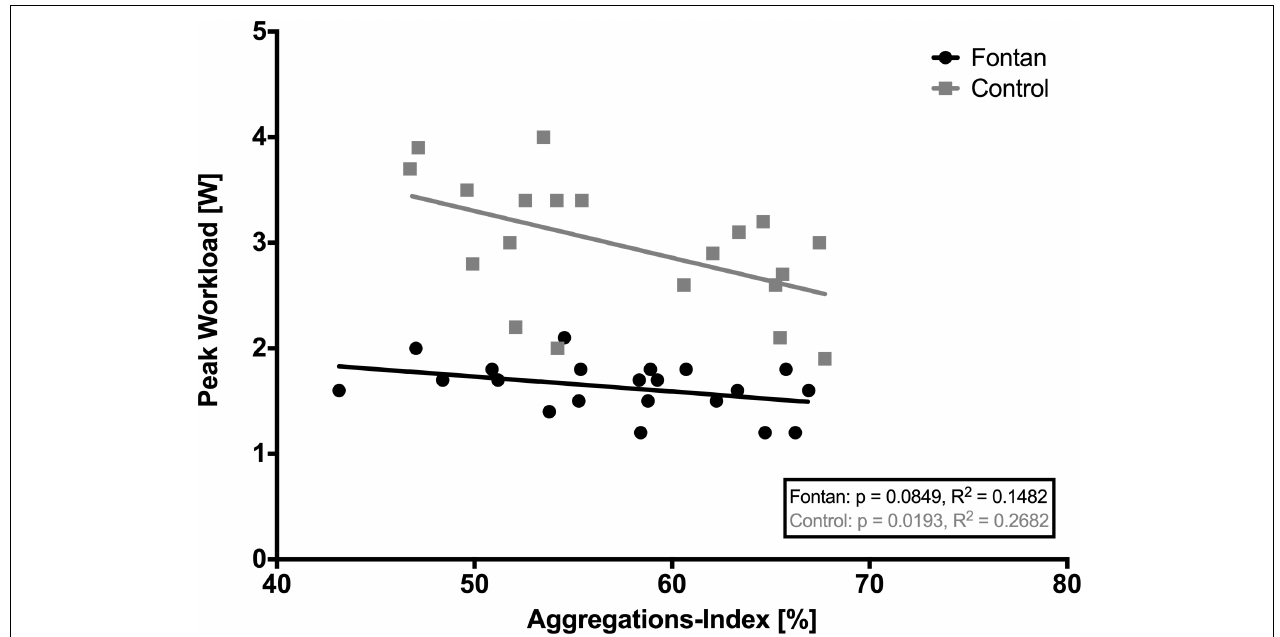
FIGURE 7 | Correlation of aggregations-index (AI) and peak workload. A statistically significant correlation between AI and peak workload could be demonstrated in the control group. Possibly this correlation could not be seen in the Fontan group, because Fontan patients might not have reached their individual maximum physical